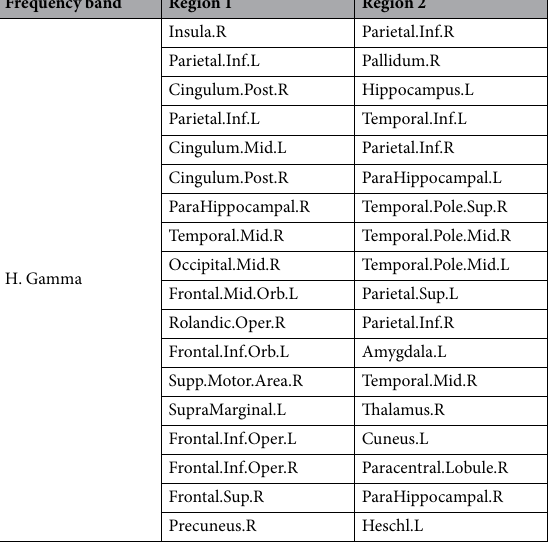
Table 2. Edges selected by the SVM/rRF-FS process. Abbreviations: inf, inferior; sup, superior; mid, middle; orb, orbital; tri, pars triangularis; oper, operculum; ant,